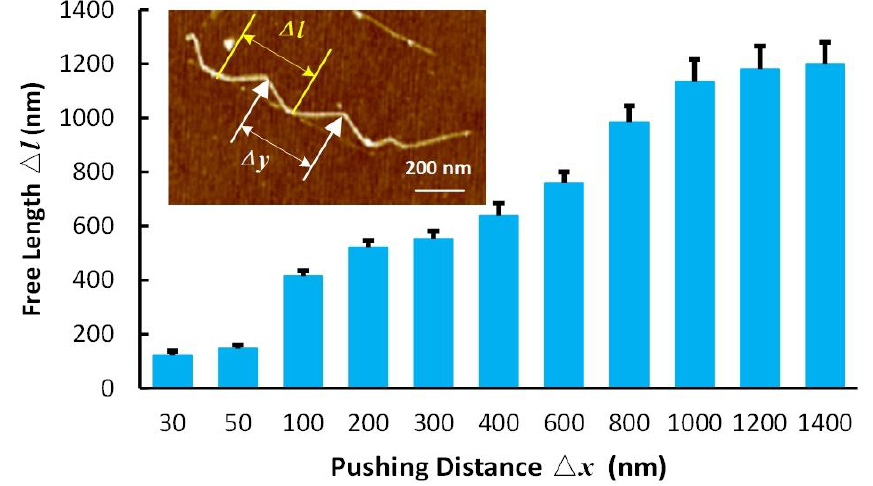
Figure 3. Carbon nanotube (CNT) bending test by atomic force microscopy (AFM) pushing operation with a single path. The bar chart describes the free length Δ l under pushing distance Δ x used in our study. The inlet image is the AFM image illustrated the free length and the interval between adjacent pushing path Δ y.